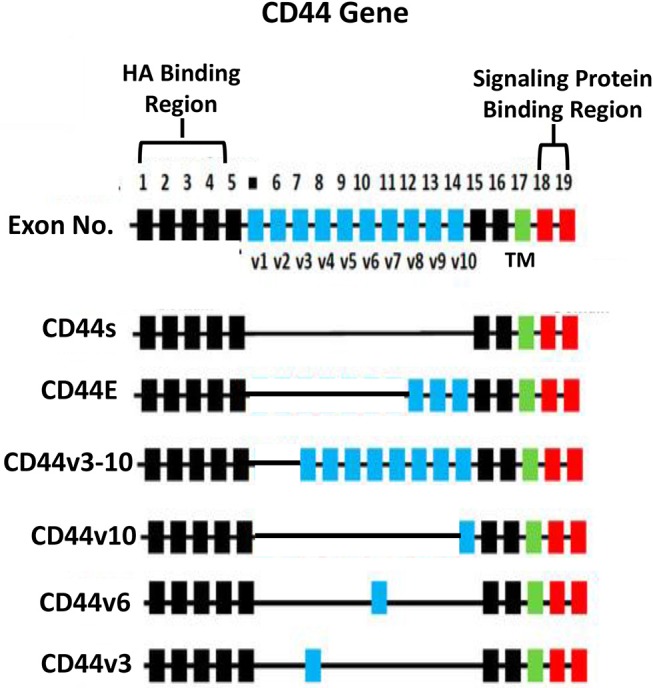
Illustration of CD44 gene, CD44s (the standard form) and alternative spliced variants (CD44E, CD44v3-10, CD44v10, CD44v6, and CD44v3 isoforms). The HA binding domain is located at the external (N-terminal exon 1–5) region of all CD44 isoforms and the signaling protein binding sites are located at the cytoplasmic domain (exon 18–19) of CD44 isoforms. All isoforms contain a transmembrane domain (TM) (exon 17).